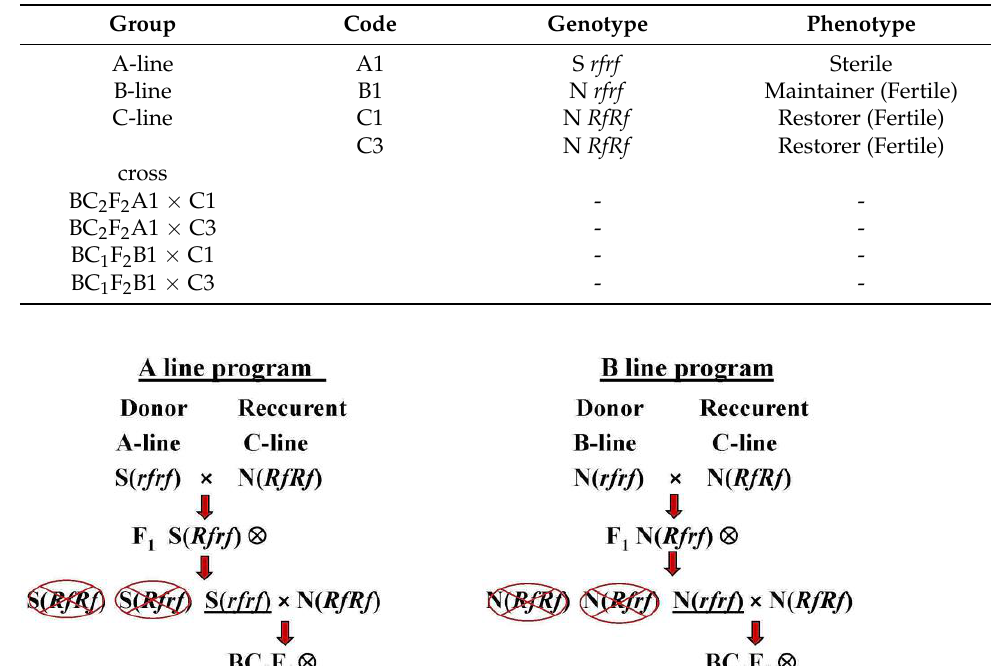
Table 1. Description of chili lines used in this study.